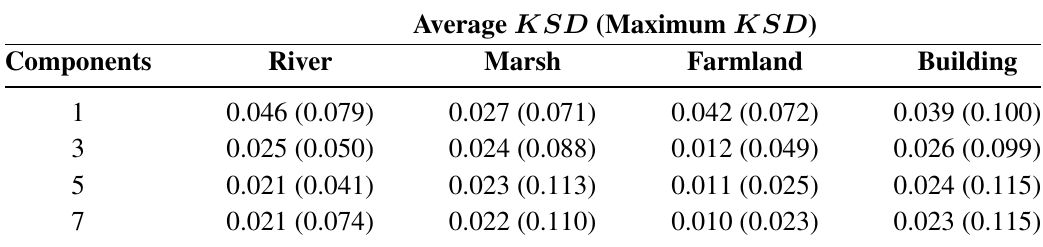
Table 4. Mixture of Alpha-stable distributions for modeling various SAR images.